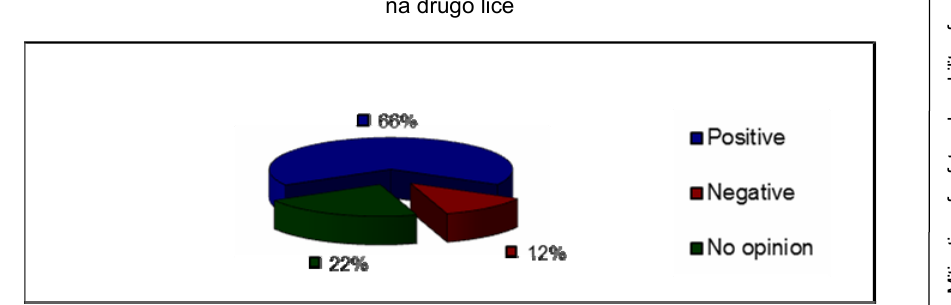
Figure 6 – Assessment of the division of hazards, risks and threats from the explosion of explosive materials into more smaller